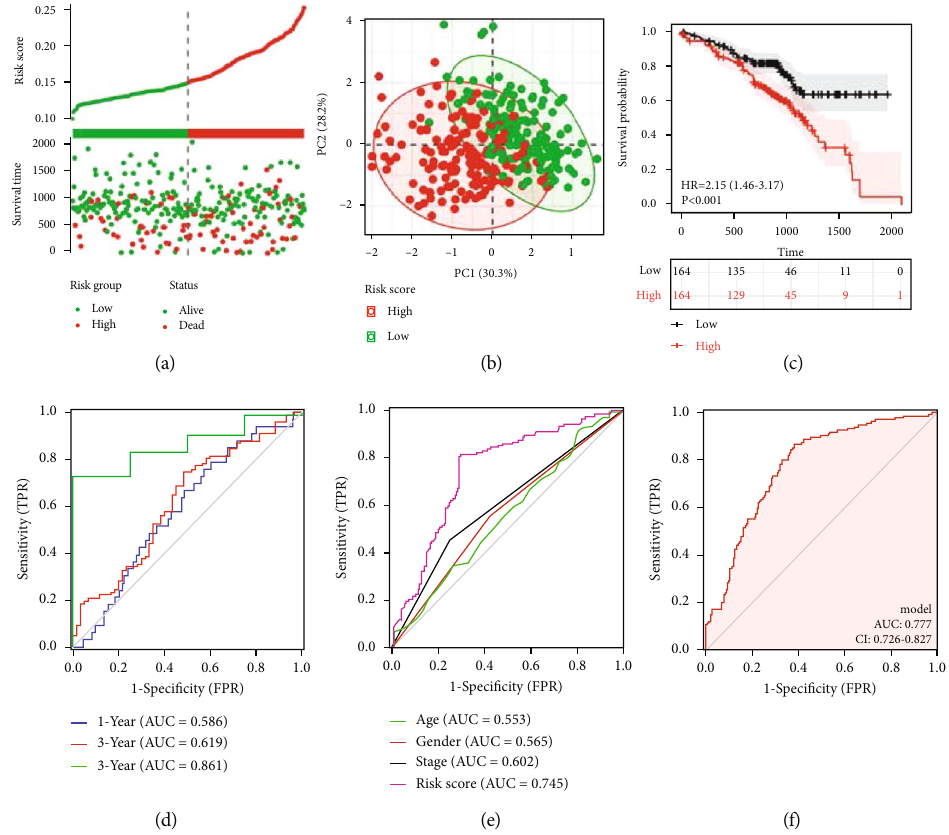
Figure 5: Validation of the CTCR model in the GSE72094 dataset (n =328). (a) Survival status and risk scores in the validation cohort. (b) PCA analysis of grouped samples in the validation cohort. (c) KM curves demonstrating longer OS in the low-risk group. (d) AUC values of time-dependent ROC curves verify the predictive accuracy of the risk score. (e) Comparison of ROC curves among patients with di ff erent clinical characteristics, such as age, sex and stage, and risk scores in the validation cohort. (f) ROC curve based on risk scores and other prognostic